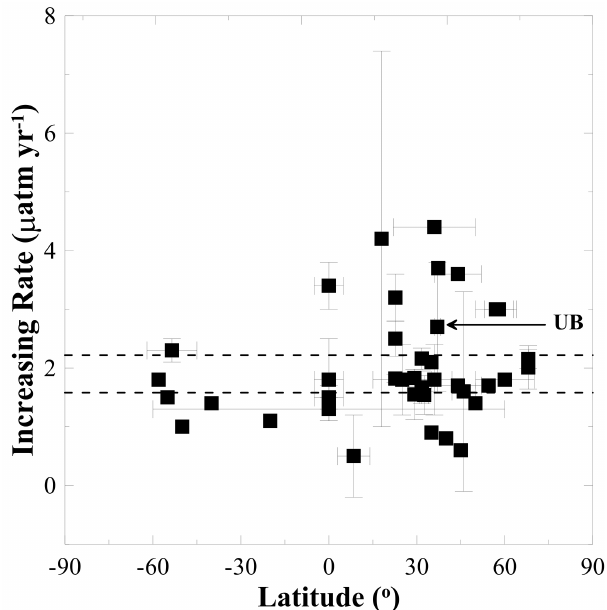
Fig. 6. A plot of the rate of increase of surface seawater CO 2 ver- sus latitude. Dashed lines represent the range of long-term trend at major ocean time-series stations (Rhein et al., 2013).